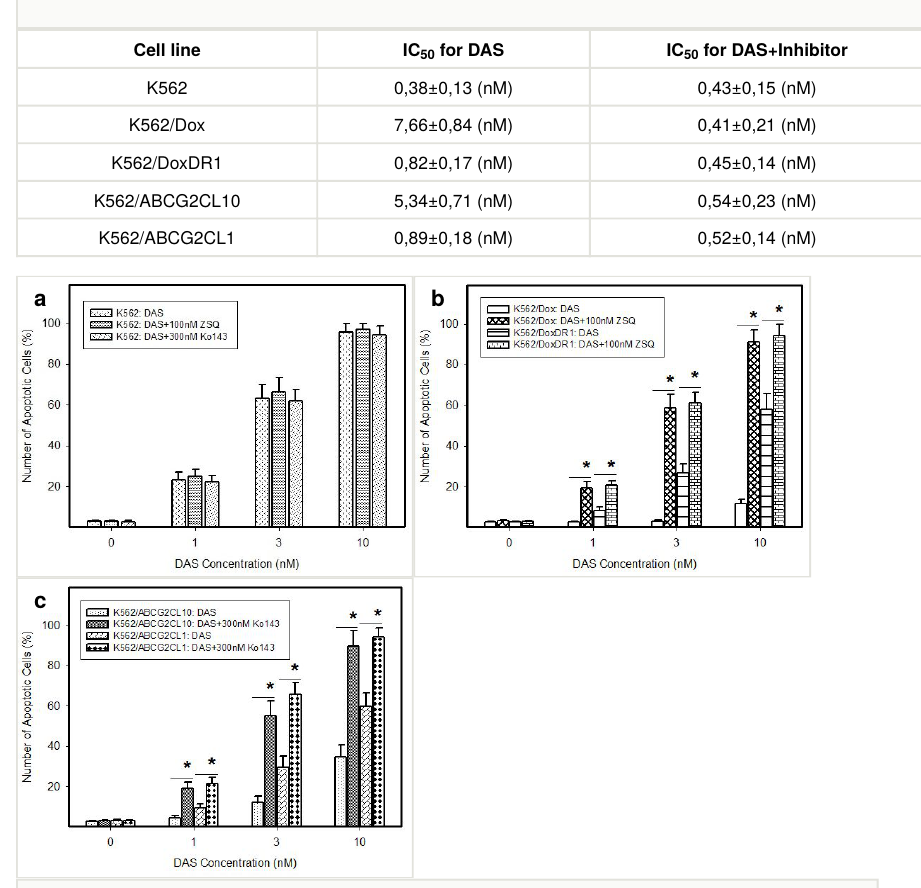
E ff ect of DAS on cell survival and viability in cells with high and low expression levels of ABCB1 and ABCG2. Cells were treated with DAS for 48h prior to MTT assay.